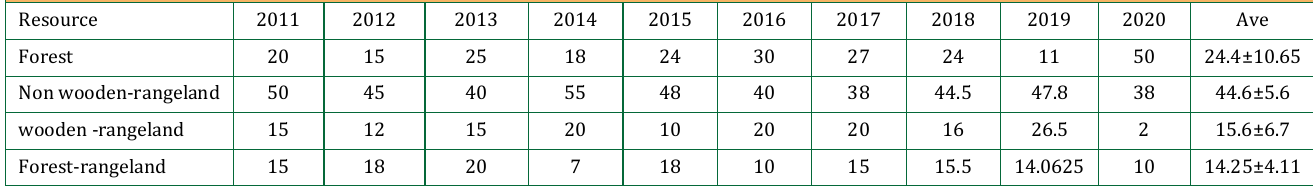
Table 1: Frequency of fires in various sources from 2011 to 2020